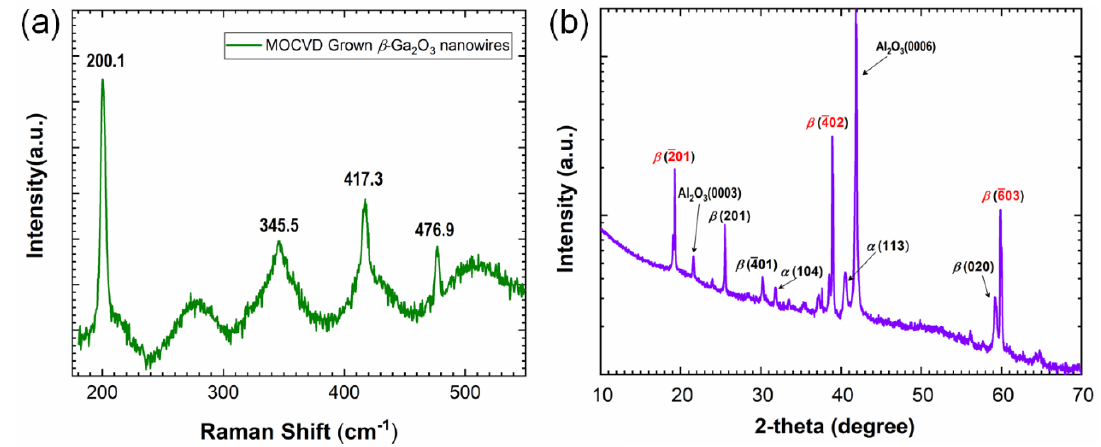
Figure 4. ( a ) Raman and ( b ) X-ray diffraction (XRD) spectra of β -Ga 2 O 3 nanowires.